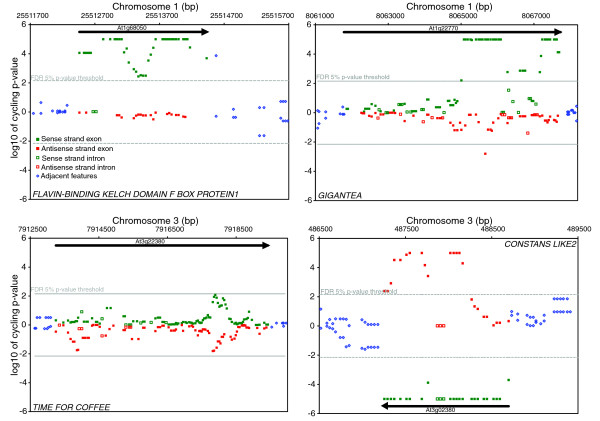
The Arabidopsis tiling arrays portray several interesting classes of circadian behavior in the genome. Each symbol is a feature on the tilling array showing location in the genome (x-axis) and significance of the spectral analysis (y-axis) for (a) FLAVIN-BINDING KELCH DOMAIN F BOX PROTEIN1, (b) GIGANTEA, (c) TIME FOR COFFEE, and (d) CONSTANS LIKE2. The top half of each panel displays the Watson strand and the bottom half the Crick strand. Individual features that exceed the false discovery rate 5% p-value threshold (-) are considered to have a circadian rhythm.